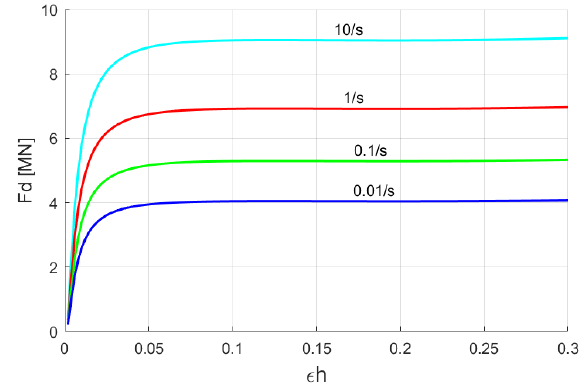
Figure 5: Curves of the predicted hot flow stress σ p as a function of the unit draft ε for different deformation strain rates ˙ φ and h constant deformation temperature T = 900 ∘ C